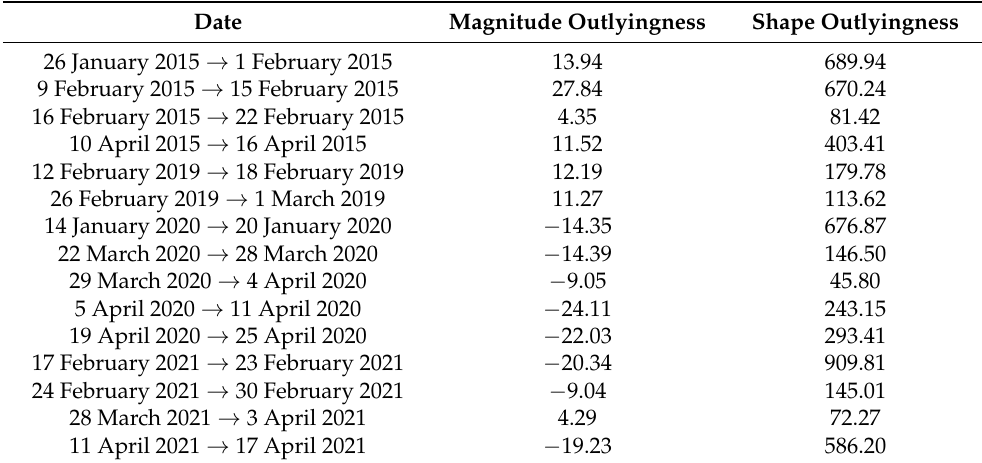
Table 1. Weekly NO 2 outliers of the improved method with the modified band depth. The first column includes those outlying weeks of the first four months of every year, defined by their first and last day. The second column presents the magnitude outlyingness of those functions, which quantifies how much a function is shifted compared to the rest. The last column shows the shape outlyingness, a parameter that expresses to what degree a function has a different structure than the